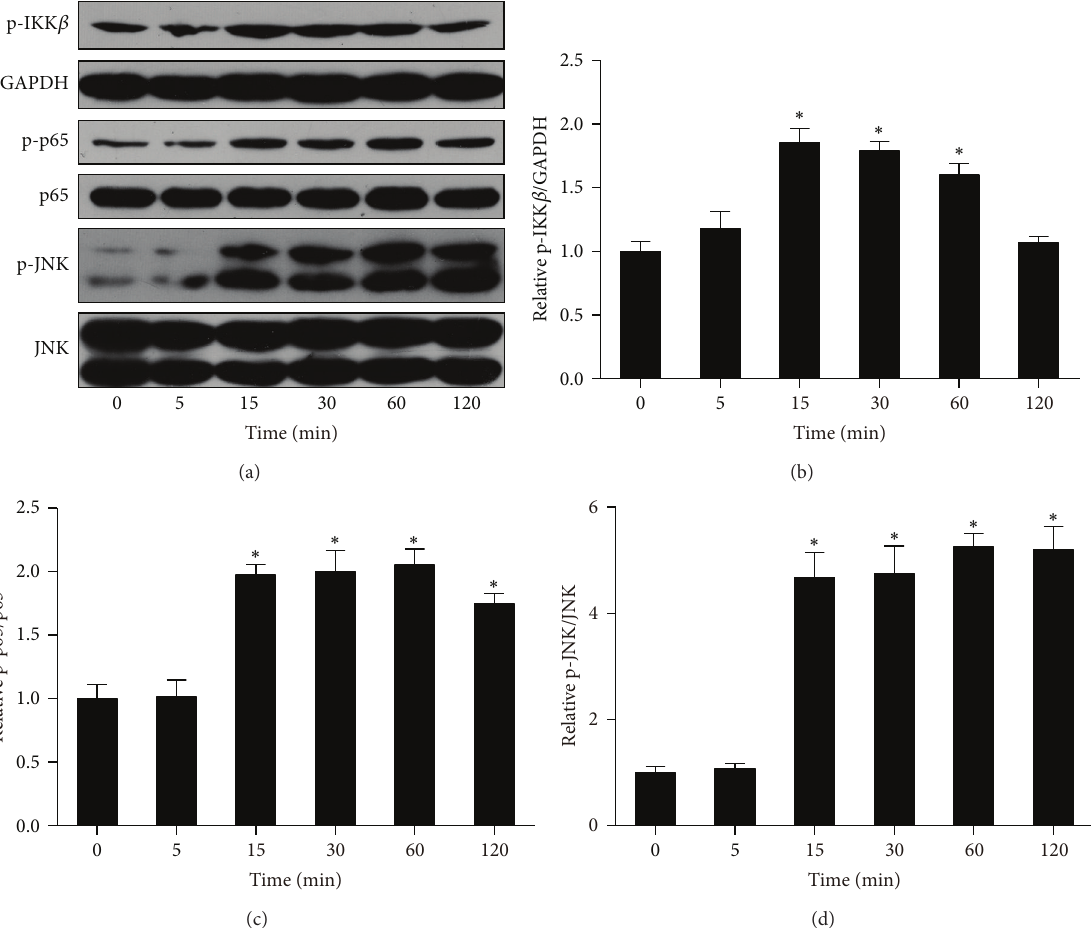
Figure 6: FSTL1 activates proinflammatory signaling pathways in 3T3-L1 adipocytes. Differentiated 3T3-L1 adipocytes were treated with recombinant mouse FSTL1 (100ng/mL) for indicated time periods (0–2h). (a) Expression and phosphorylation of IKK 𝛽 , NF 𝜅 B, and JNK were assessed by Western blot analysis. (b) and (c) Intensity of bands was quantified by densitometry and expressed as ratio of phosphorylated to total protein. The ratio was normalized to control. Data are mean ± SE; 𝑛 = 3 . ∗ 𝑃 < 0.05 versus control (0 min).